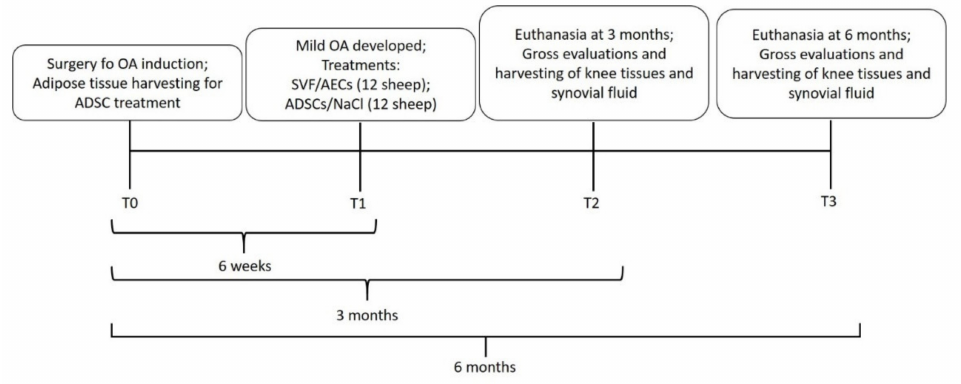
Figure 1. Schematic representation of the timeline of the